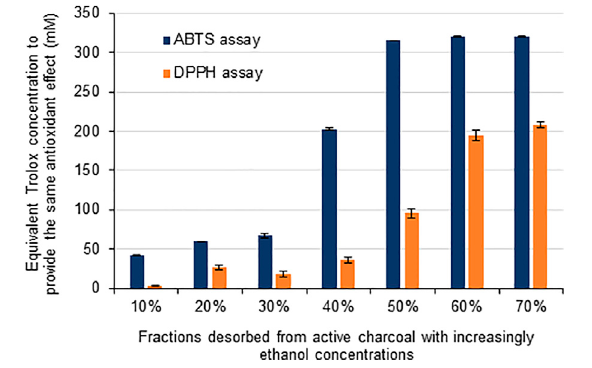
FIGURE 6 | Correlation of total phenolic contents detected in xylooligosaccharide fractions desorbed from active charcoal by increasing ethanol concentrations and their antioxidant activity revealed by ABTS radical scavenging assays. Trolox at varied concentrations is shown in